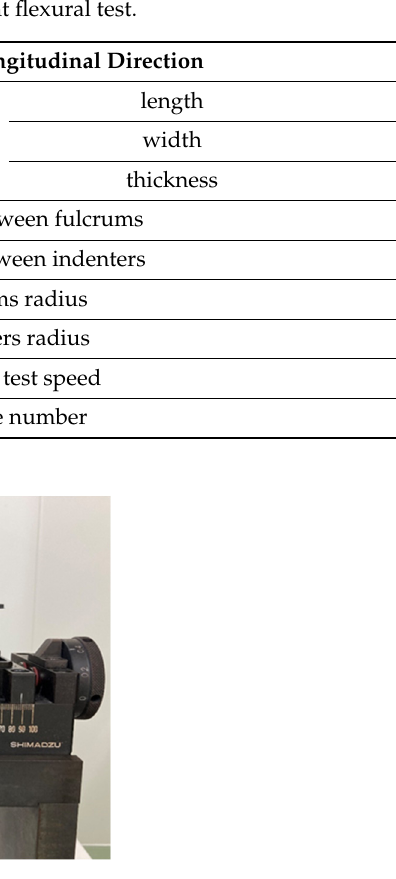
Figure 6. Four-point flexural test’s jig (Shimadzu Co. Ltd., Kyoto Japan).